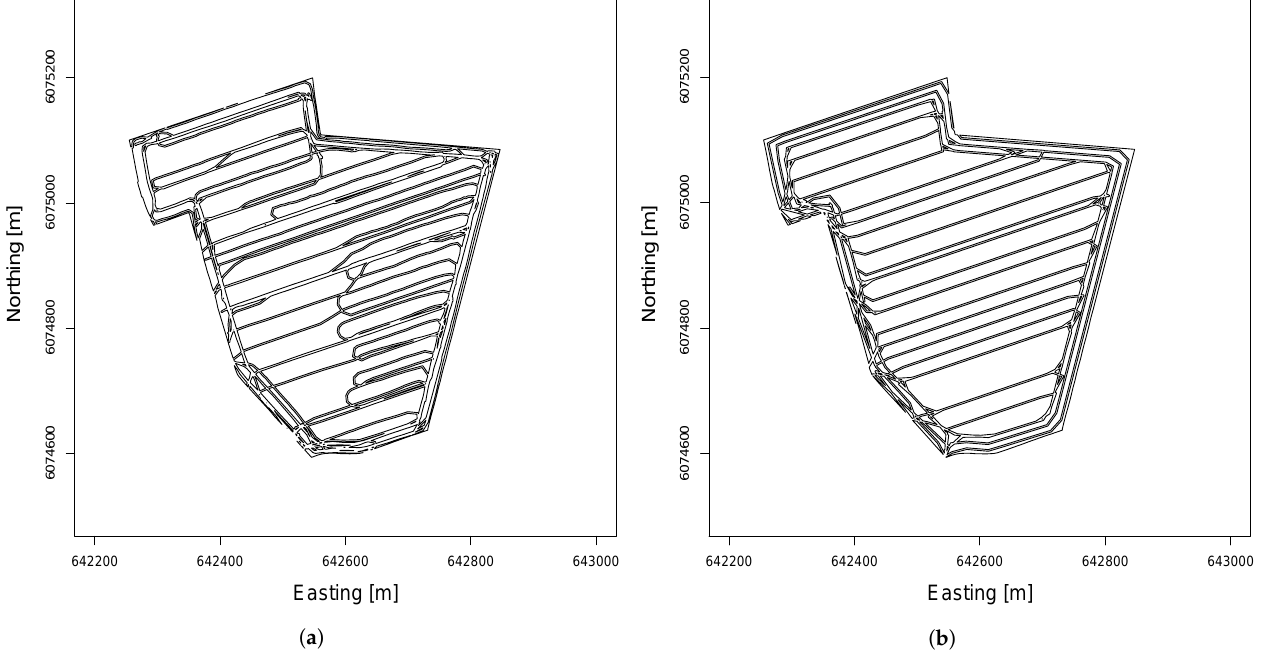
Figure 8. ( a ) In-field SU transport for recorded data. ( b ) In-field SU transport for optimised routes. Comparison of in-field area coverage with SU traffic for Field 7. Both SU A and B routes, including overlaps, are represented as coverage polygons inside the field. The simulated optimised route plan resulted in a 15.9% area coverage ( b ), and derived from the recorded driving of SUs the area coverage was 21.7% ( a ).